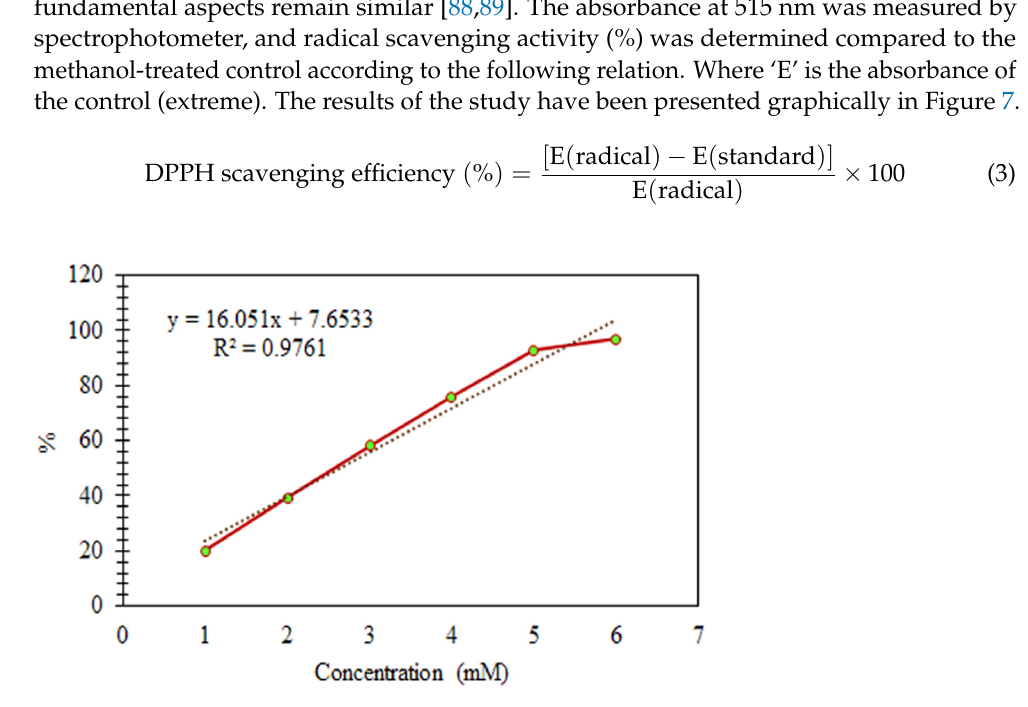
Figure 7. Antioxidant Activities of the Standard (Ascorbic